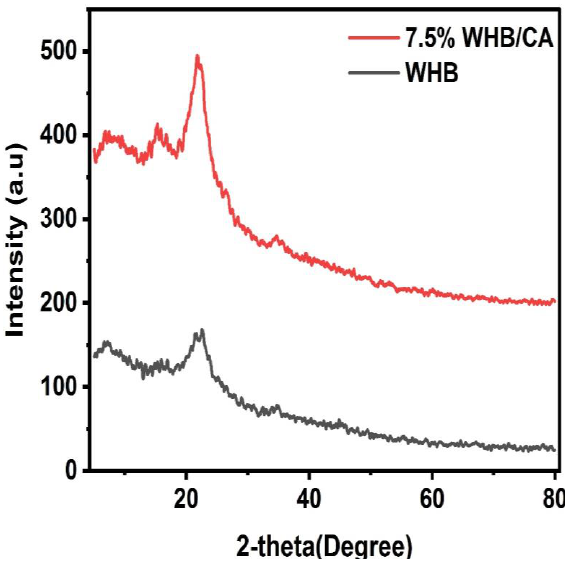
Figure 2. XRD of WHB and 7.5%WHB/CA.